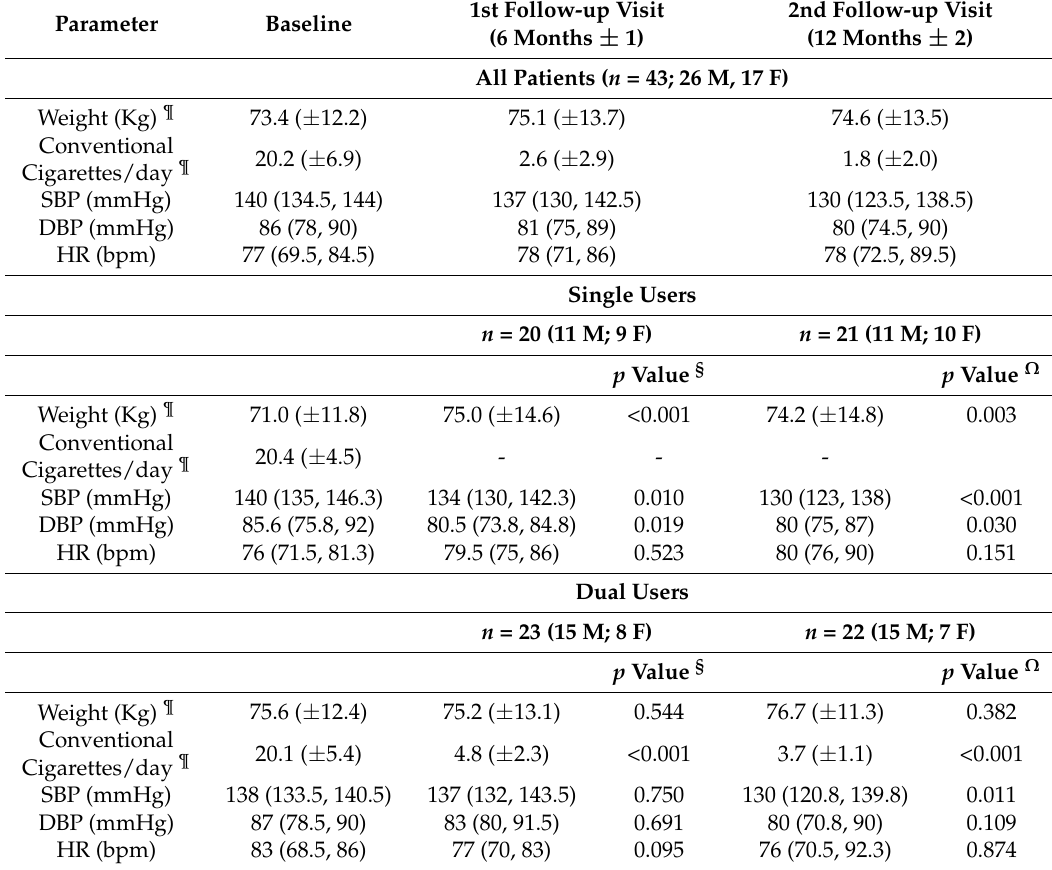
Table 3. Parameters measurements at baseline, 6- and 12-months for the E-Cigarette group